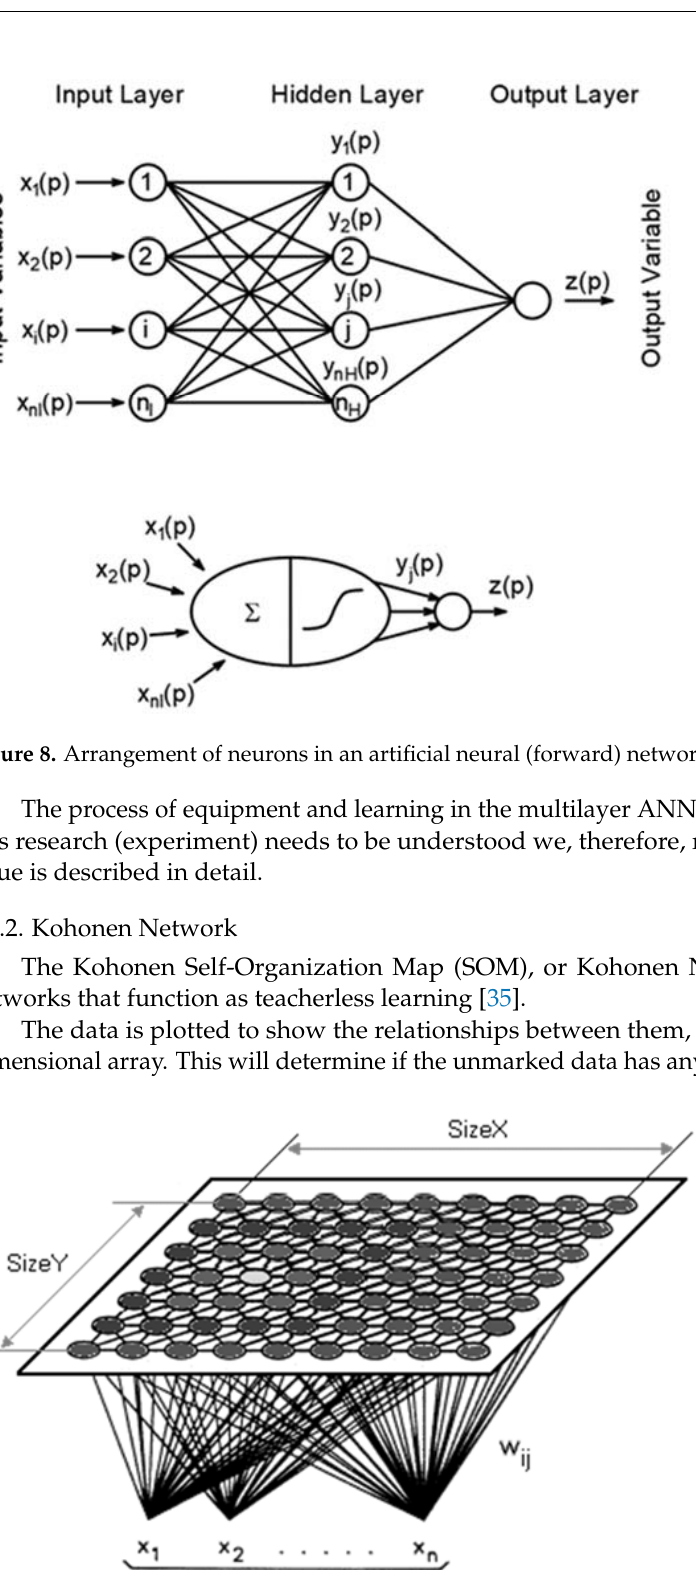
Figure 9. Example of kohonen network arrangement.